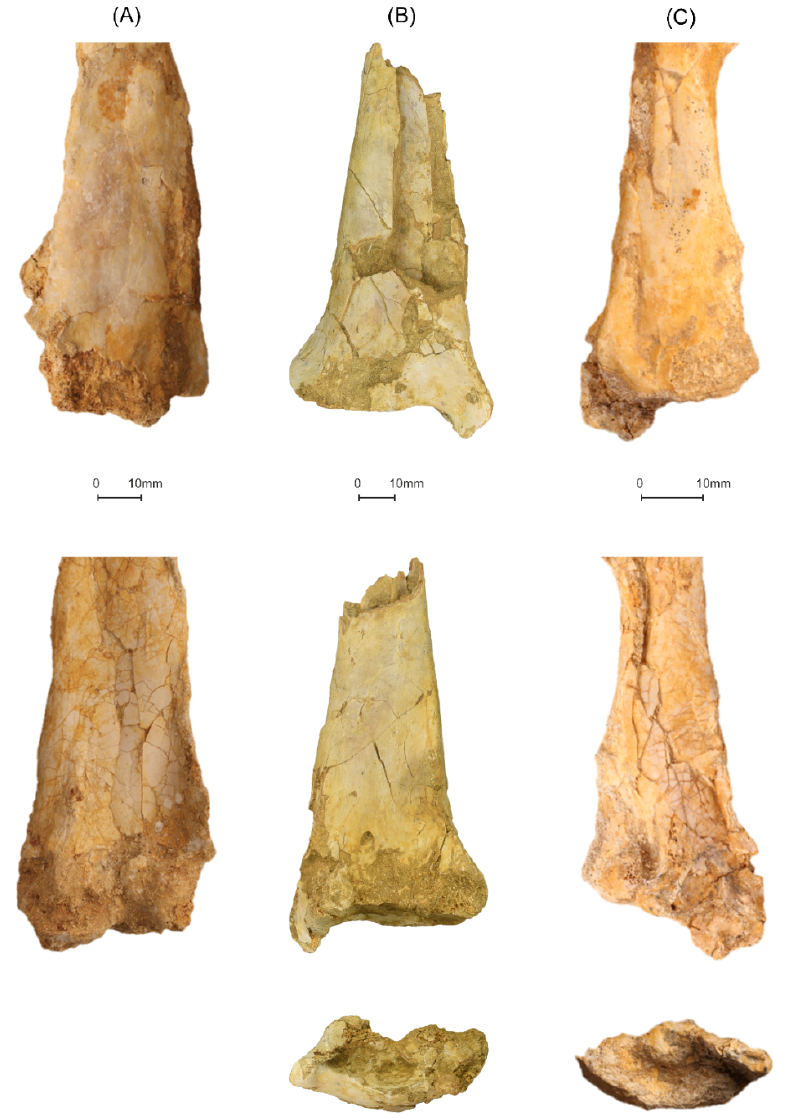
Figure 12. Comparison of non-nyctosaurid pteranodontian distal humeri. ( A ) FSAC-OB 7 Simurghia robusta Longrich et al. 2018 [17], ( B ) MGUAN-PA650 Epapatelo otyikokolo , and ( C ) FSAC-OB